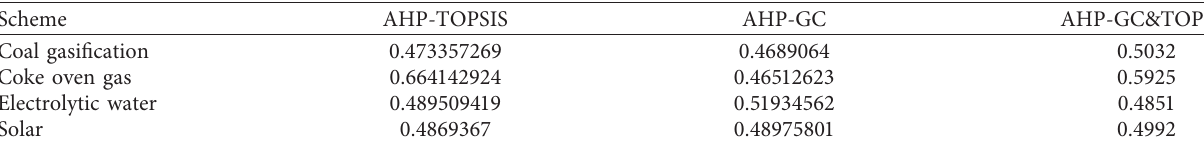
Table 4: Comparison with AHP-TOPSIS and AHP-GC.